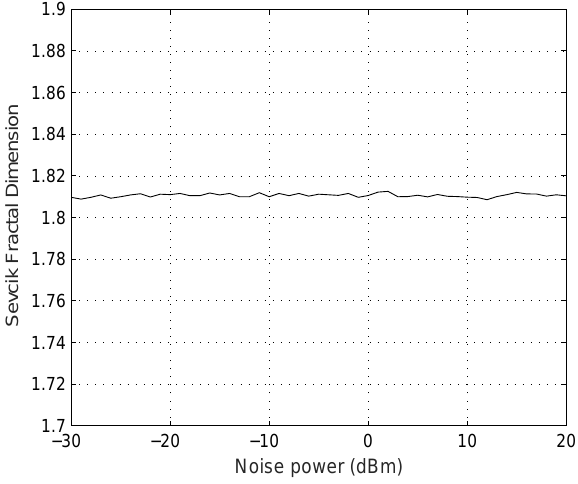
Figure 2. The relationship between noise power and the noise Sevcik fractal